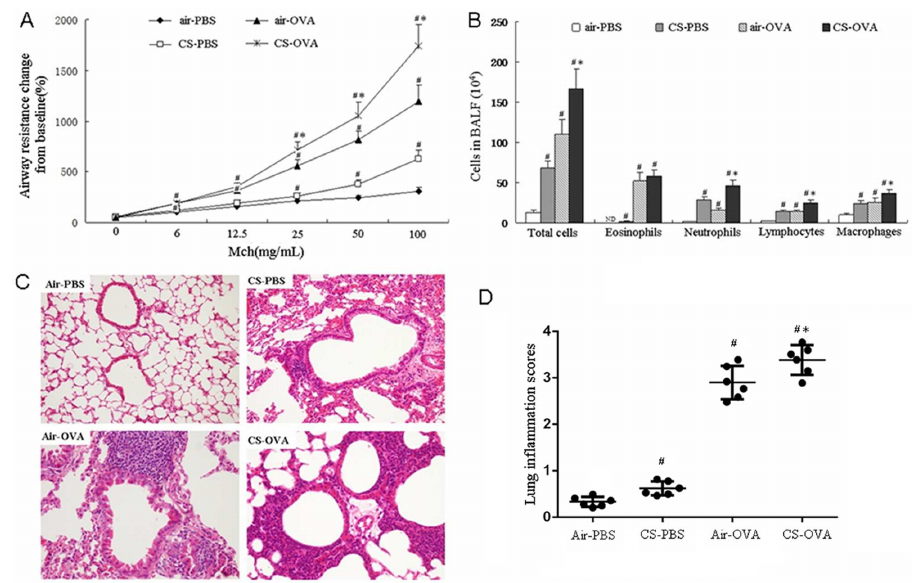
Fig 2. Early-life CS exposure aggravated asthmatic airway inflammation. (A) Pulmonaryresistancewas analyzedwith the flexiVent forced oscillationtechnique(SCIREQ). Pulmonary resistancewas measuredin responseto methacholine (MCh) at the indicatedconcentration in the air exposurewith PBS sensitization(air- PBS), CS exposurewith PBS sensitization(CS-PBS), air exposure with OVA sensitization(air-OVA), and CS exposurewith OVA sensitization (CS-OVA) groups. The percentage rates of the baselinewere normalized to 100. (B) The numbers of eosinophils, neutrophils, lymphocytes, macrophages, and total cells were countedin the BALF of the air-PBS, CS-PBS, air-OVA, and CS-OVA groups. (C) HE stainingof lung sections from the air-PBS (upper left), CS-PBS (upper right), air-OVA (lower left), and CS-OVA (lower right)-treated mice. (D) The degreeof inflammation of the groupsin (C) was analyzedby scoringthe cells aroundthe airways (0, no cells; 1, a few cells; 2, a ring of cells 1 cell layer deep; 3, a ring of cells 2–4 cell layers deep; and 4 with a ring of cells more than 4 cell layers deep) in the four groups. All values are the means ± SD of the results from 6 mice per group. # P < 0.05 vs. Air-PBS group; * P < 0.05vs. Air-OVA group.